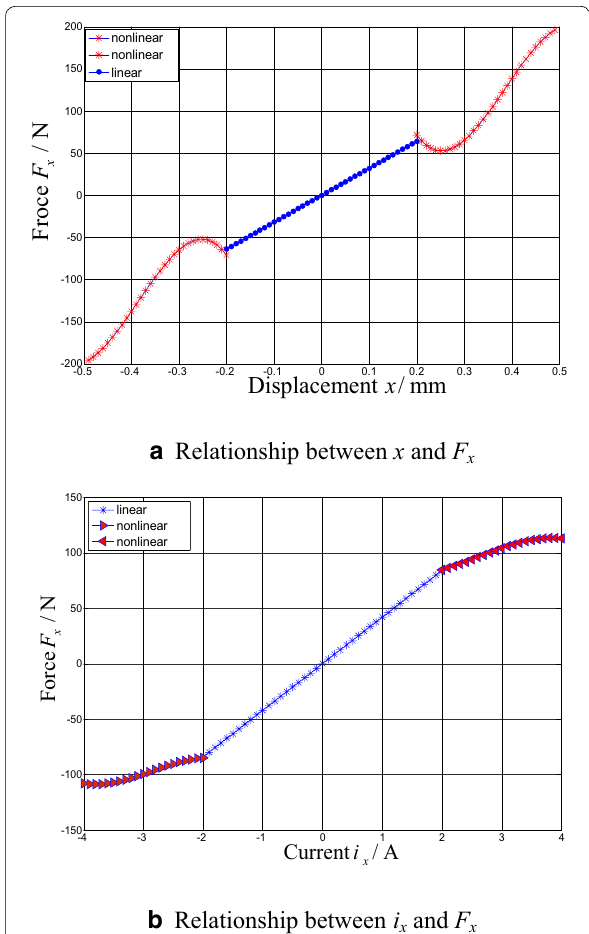
Figure 9 Relationship between x, i x and F x